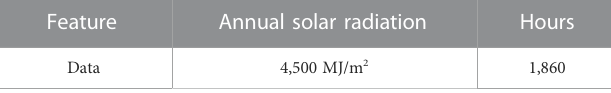
TABLE 1 Weather data in Kitakyushu (JMA, 2022).